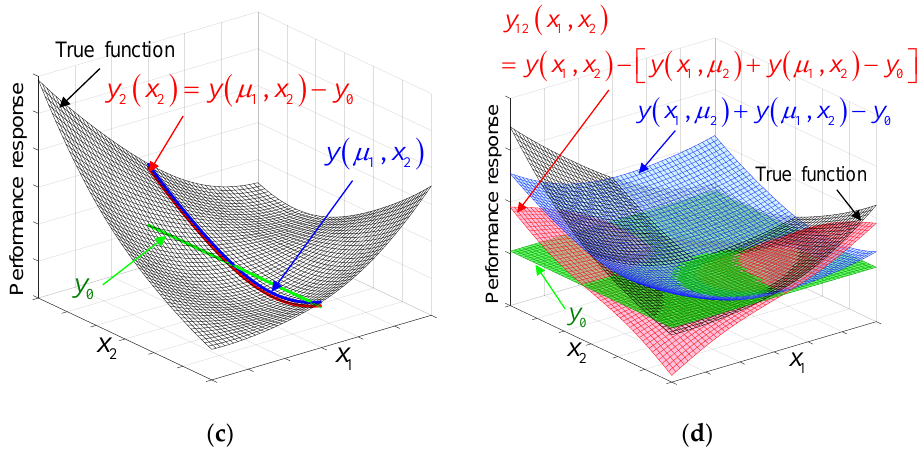
Figure 1. Illustration of Bivariate Cut-HDMR using an arbitrary 2D function; ( a ) 2D function and the effect of zeroth-order, ( b ) the main effect of x 1 , ( c ) the main effect of x 2 , and ( d ) the interaction effect of x 1 and x 2 .